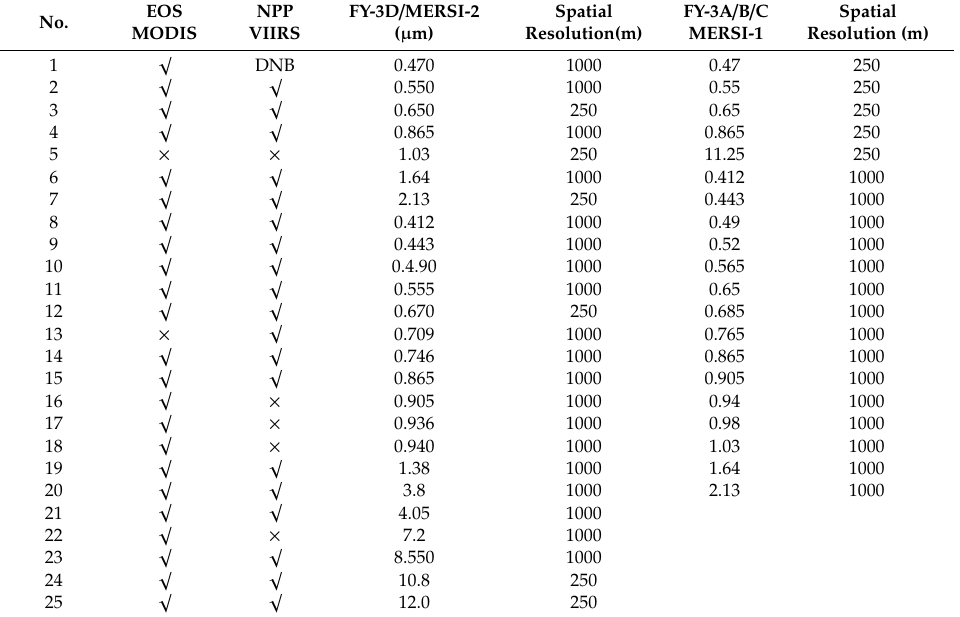
Table 2. Sensor characteristics commonly used for retrieving land surface temperature (LST).